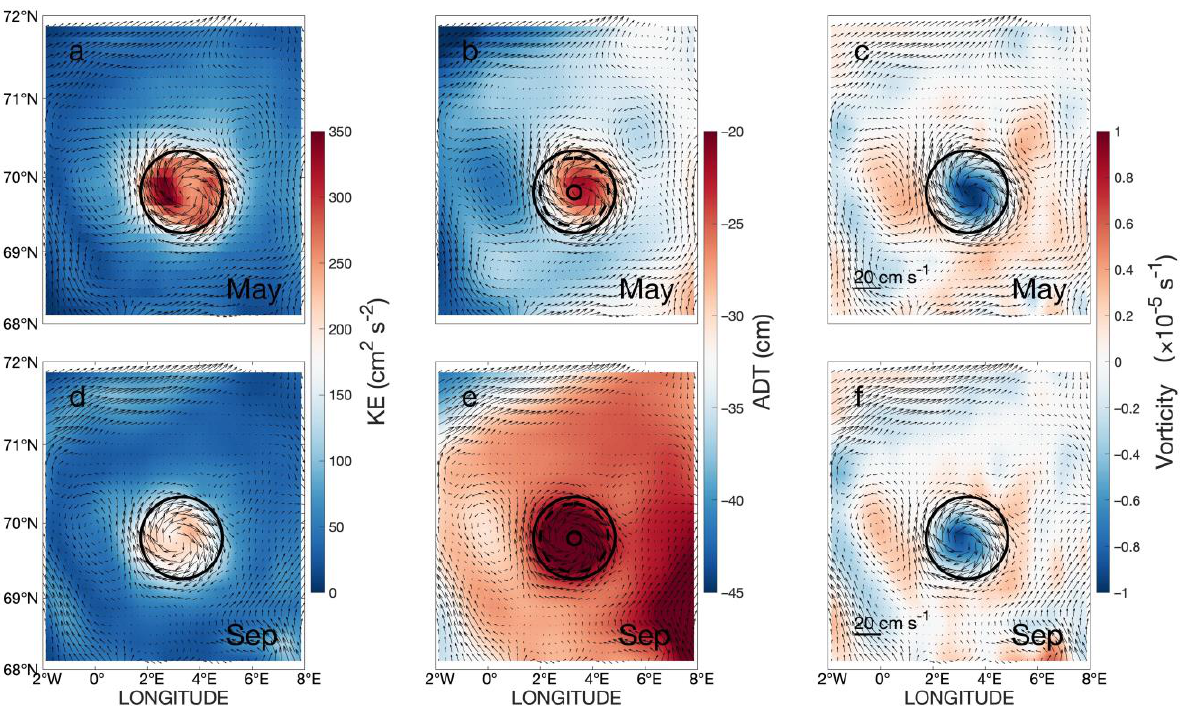
Figure 6. Seasonal comparison of the physical characteristics of the CLV. The upper panels show the climatological characteristics in May: ( a ) kinetic energy, ( b ) ADT, and c) vorticity. The lower panels ( d – f ) are the climatological characteristics in September.